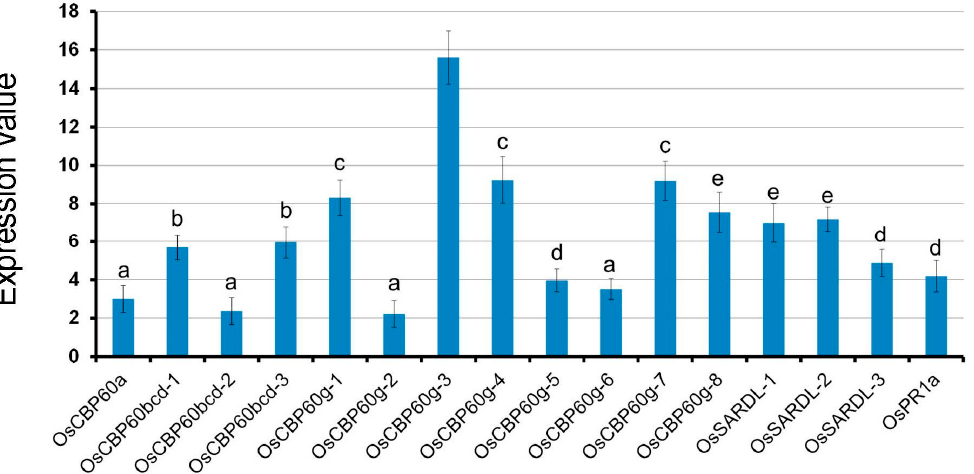
Figure 10. Transcriptional response of OsCBP60 genes in rice seedlings treated with brassinosteroid. Rice seedlings were grown for 15 days on MS medium supplemented with 1 µ M EBR. Relative transcript abundance (expression value) is expressed as fold-change relative to the mock treatment. Since EBR enhanced AtPR1 expression [52], OsPR1a expression was studied as a probable positive control. Results are representative of three independent experiments. Error bars represent standard error (SE) of mean for three replicates. Superscripts with the same letter are not significantly different ( p < 0.05) by one-way ANOVA-protected LSD